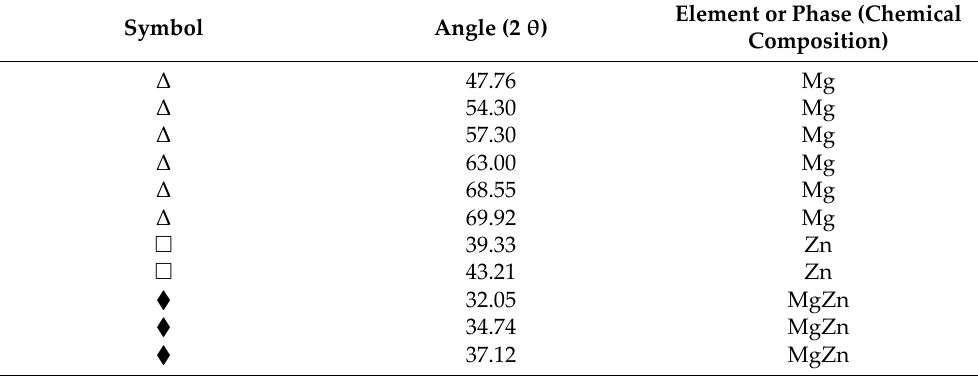
Table 3. Angles in the XRD patterns (Figure 7) and their corresponding phases.